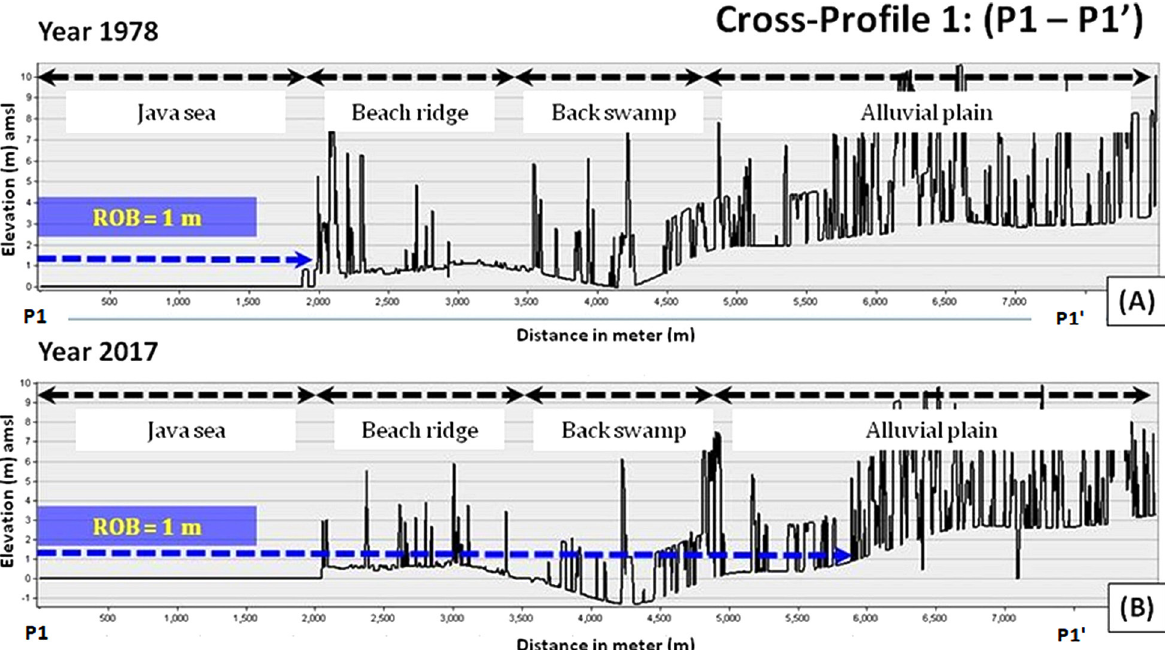
Fig. 8. Comparison results for morphological and topographic condition change from DEM modelling between 1978 and 2017 on cross-profile 1 (P1–P1’) and their implications for vertical tidal flood distribution in coastal landform areas.